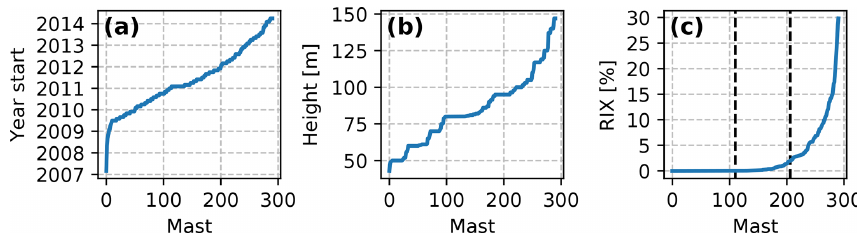
Figure 5. Ranked values of metadata variables for the 291 masts: (a) the start year of the 1-year period, (b) the height a.g.l. of the wind speed measurements, and (c) the ruggedness index (RIX). The dashed vertical lines in (c) shows the separation (greater than 0% and greater than 2%) of the masts into groups by RIX.